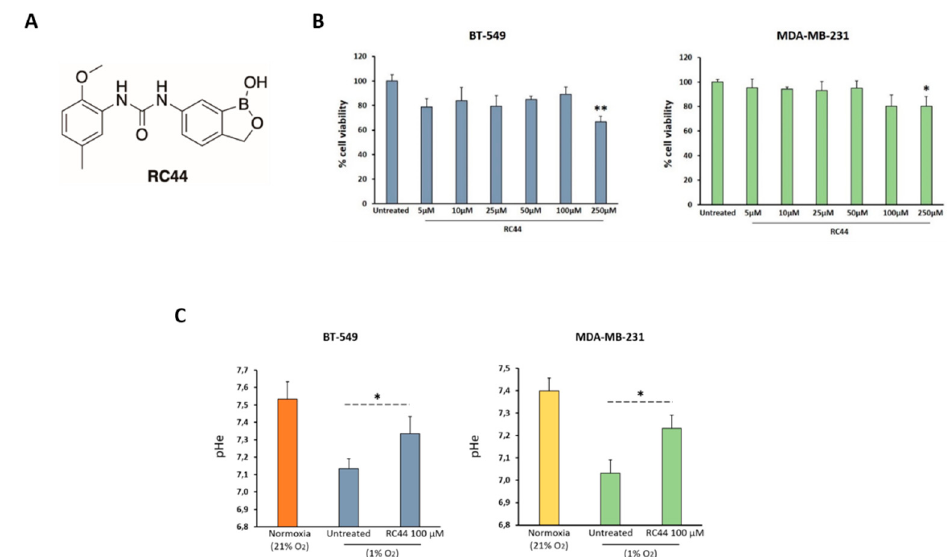
Figure 3. ( A ) Chemical Structure of CA inhibitor RC44. ( B ) Effect of CA inhibitor RC44 on TNBC cell proliferation. Cell viability (MTS assay) of BT-549 and MDA-MB-231 (50 × 10 3 cells/well), treated with different concentrations of RC44 (from 5 µM to 250 µM) for 72 h in hypoxic conditions (1% O 2 ). All the data are expressed as percentage of viable cells, considering the untreated control cells as 100%. ( C ) Effect of RC44 on extracellular pH (pHe) in hypoxia. BT-549 and MDA-MB-231 were grown under normoxic (21% O 2 ) and hypoxic conditions (1% O 2 ) for 72 h and treated with RC44 (100 µM) when grown in hypoxia. Bars depict mean ± SD of three independent experiments. (** p < 0.001; * p <